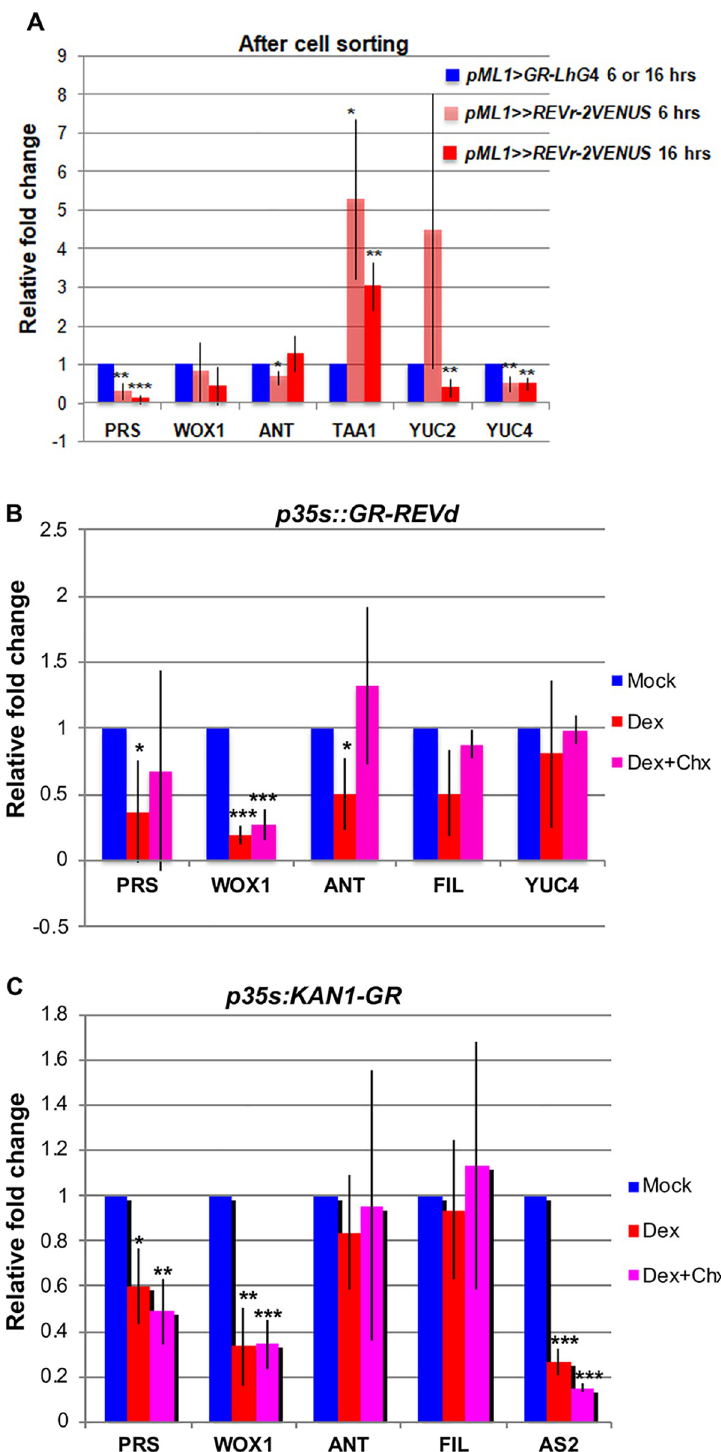
Fig 3. Q-PCR validation of selected genes. (A) Q-PCR analysis of selected genes in pAtML1 >> REVr-2VENUS and pAtML1 :: GR-LhG4;pAtML1 :: mTag-BFP-ER lines after 6 or 16 hrs of dex treatment and cell sorting with FACS. (B) Q-PCR analysis of selected genes in p35s :: GR-REVd line after mock or dexamethasone (dex) or dex + cycloheximide (chx) treatment for 3 hrs. (C) Q-PCR analysis of selected genes in p35s :: KAN1-GR line after mock or dex or dex+chx treatment for 3 hrs. As dex was dissolved in ethanol, so in both B and C, mock refers to treatment with ethanol